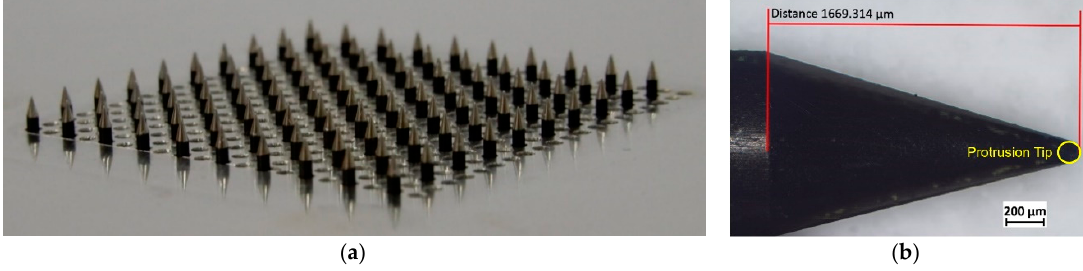
Figure 2. Protrusion array. ( a ) Protrusion array with 100 protrusions. ( b ) Protrusion tip details.